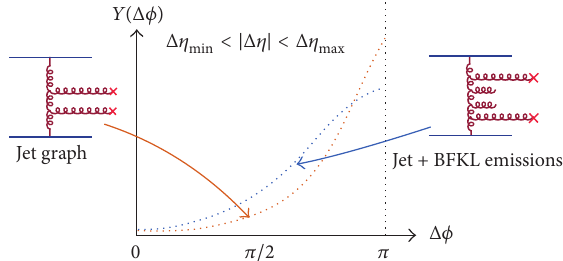
Figure 5: A cartoon showing the contributions of dijet and Glasma graphs in two-particle correlation function 𝑌(Δ𝜙) integrated over a broad range of |Δ𝜂|